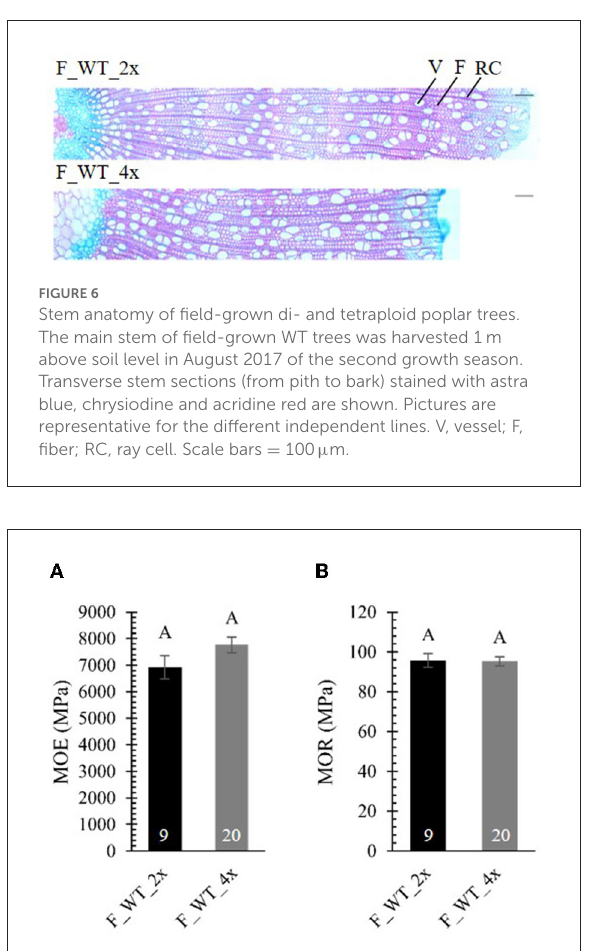
FIGURE7 Mechanical strength of field-grown di- and tetraploid poplar trees. Stem samples were subjected to a three-point bending test. From the force-displacement curve, the modulus of elasticity [MOE, (A) ] and the modulus of rupture [MOR, (B) ] were calculated. The number of biological replicates is indicated in the bars. Data shown are adjusted mean ± standard error of the mean (SEM). Different letters represent significant differences at the 0.05 significance level. For a detailed description of the models fitted to the data and the statistical tests used, see Supplementary Materials and Methods